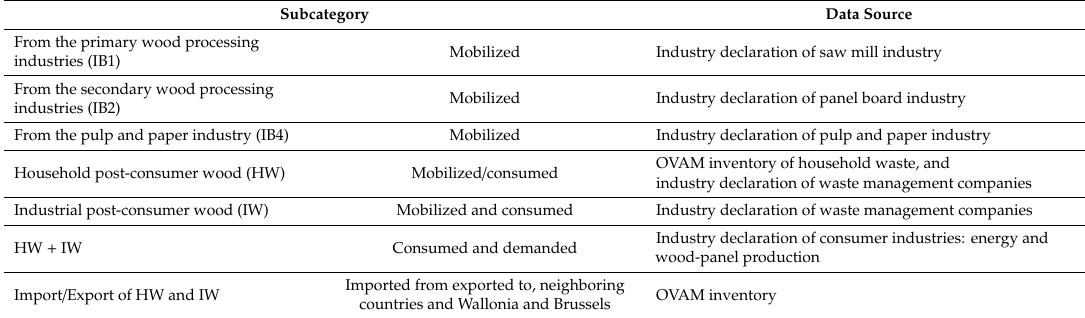
Table 5. Terminology and sources to define the waste wood balance in Flanders (OVAM = Flemish Waste Management